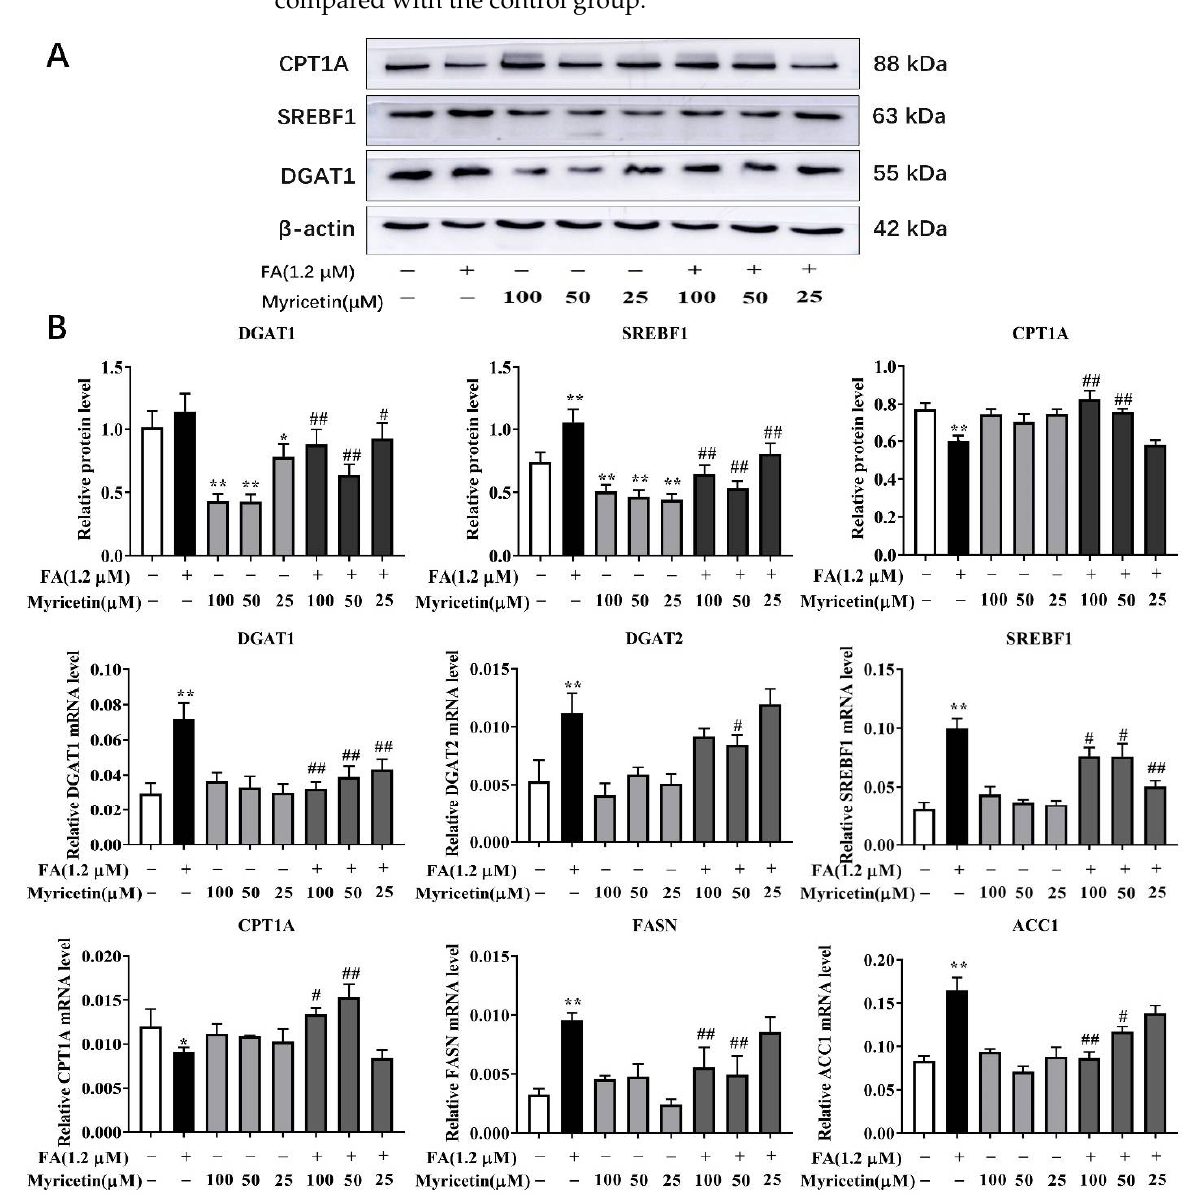
Figure 2. The effect of myricetin on key proteins and mRNA associated with lipid synthesis and FA oxidation. Hepatocytes were treated with 100 μM (M1), 50 μM (M2), 25 μM (M3), or RPMI-1640 basic medium (Control) with or without 1.2 mM FA. ( A ) Representative Western blot of SREBF1, DGAT1, and CPT1A. ( B ) Protein and mRNA abundance of SREBF1, DGAT1, DGAT2, CPT1A, ACC1, and FASN. Data were analyzed using a two-way repeated-measures (RM) ANOVA with subsequent Bonferroni correction. The data presented are the means ± SEM; * p < 0.05, ** p < 0.01 indicate differences from control. # p < 0.05, ## p < 0.01 indicate differences from cells incubated with FA.